Question: Author a descriptive caption for the visualization shown.
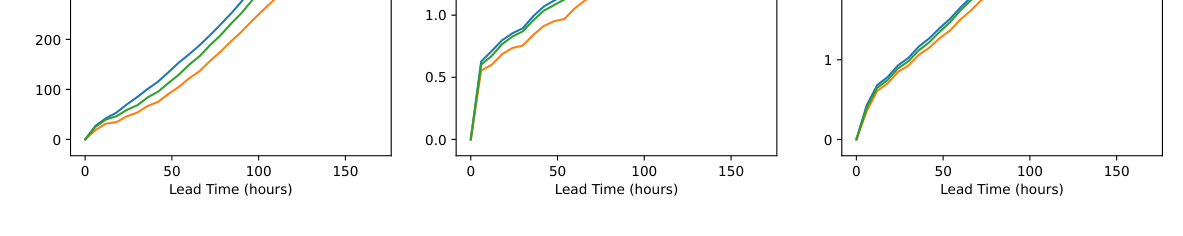
Answer: RMSE comparison of forecasts at lead times up to 7 days for the different model depth and embedding dimension for the SwinV2 model